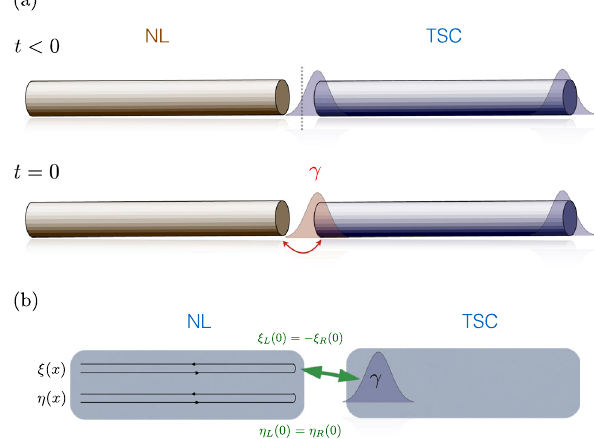
FIG. 1. Physical setup. (a) Local quantum quench considered in this paper: At time t ¼ 0 , a one-dimensional metallic (normal) lead is connected to the end of a topological superconductor with Majorana zero modes at both ends. (b) Cartoon representa- tion of the low-energy fixed point (large-time behavior) for a single-channel noninteracting lead. Only one of the Majorana channels in the normal lead ψ ð x Þ ¼ ( ξ ð x Þ þ i η ð x Þ ) = 2 experien- ces a π = 2 phase shift corresponding to the Andreev reflection ψ † ð 0 Þ ¼ ψ L ð 0 Þ at the R